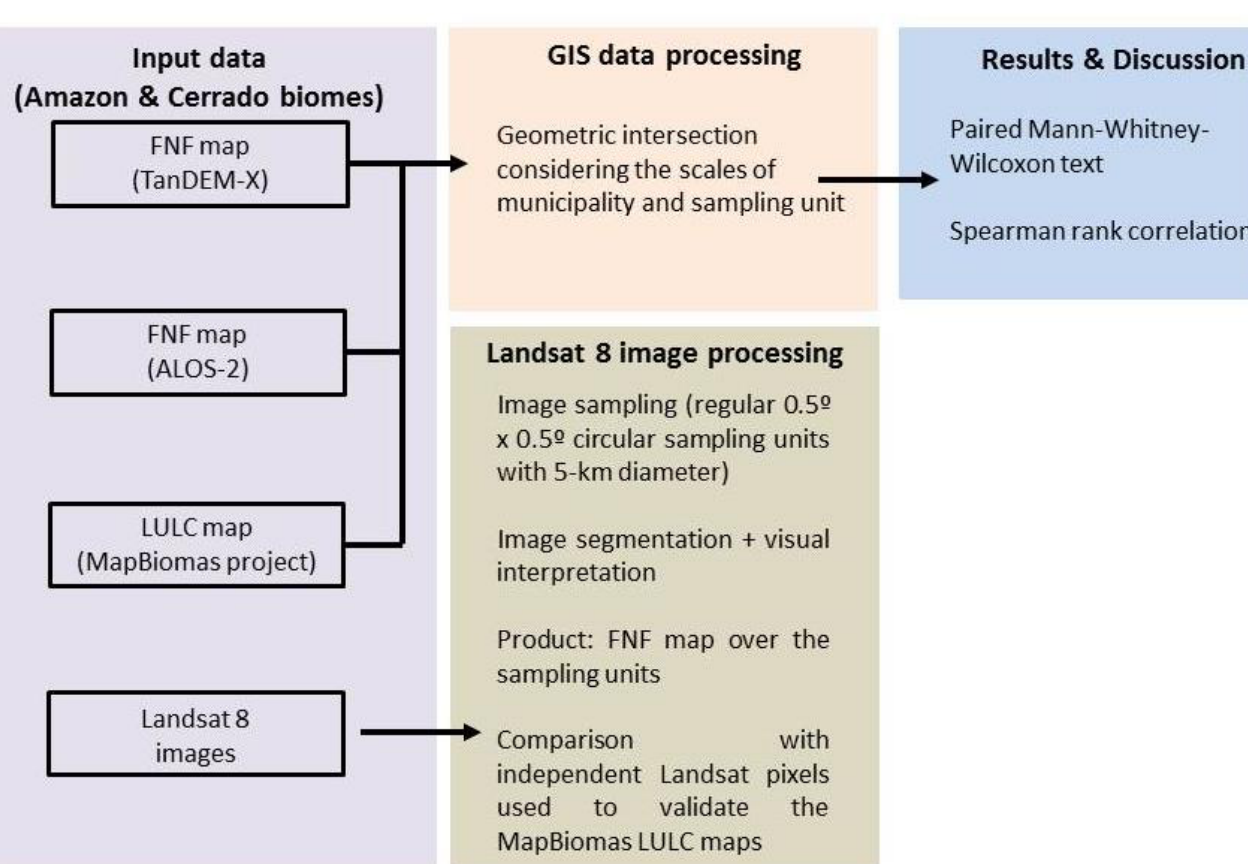
Figure 3. Flowchart showing the major steps of the methodological approach. FNF = forest/non-forest; LULC = land use and land cover; GIS = geographical information system.